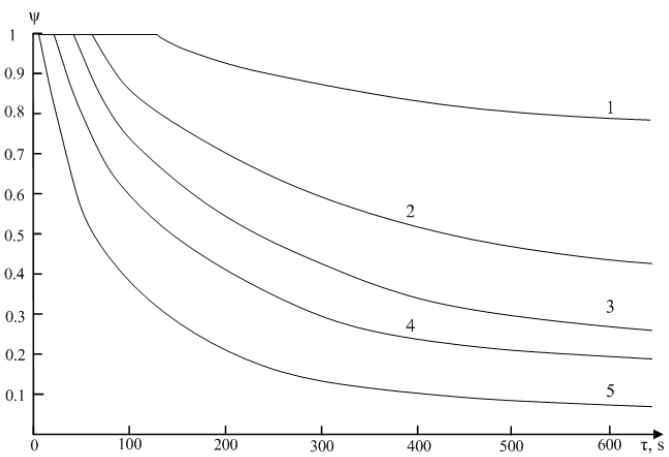
Figure 5. Time evolution of drying front in the pellet at different temperatures of the drying agent T c :